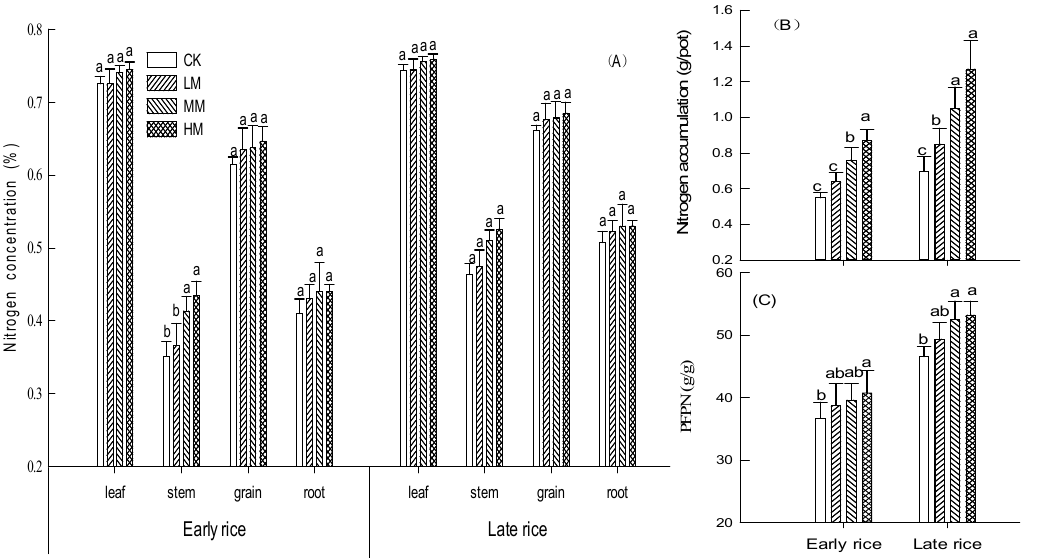
Figure 3. Nitrogen concentration ( A ), nitrogen accumulation ( B ), and PFPN ( C ) of the double cropping rice under different treatments (2018). LM, MM, and HM denote low-, middle-, and high-concentration MNBs, respectively. CK denotes the ordinary running water. The vertical bars represent ± SE of the mean. The SE was calculated across three replications. Different letters indicate statistical significance at p < 0.05.